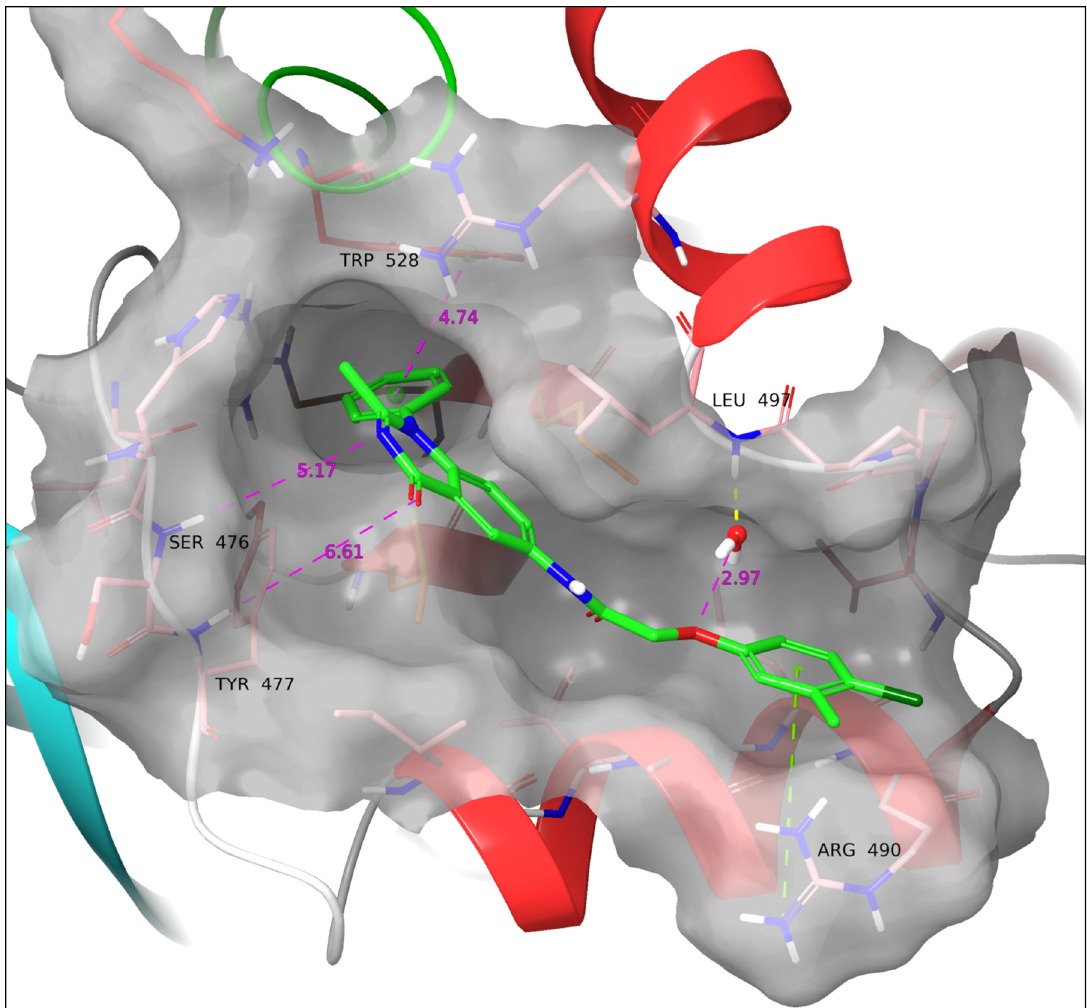
Figure 8. Docking pose of 11c . Cation– π stacking is formed with Arg490, while the ligand drifts the furthest away from Ser476 and Tyr477. Yellow dotted line: Hydrogen bond. Green dotted line: Cation– π interaction. All the above SARs were identified by employing the default settings of Maestro. Violet dotted line and number: Atom/ring distance in Å (measured manually).